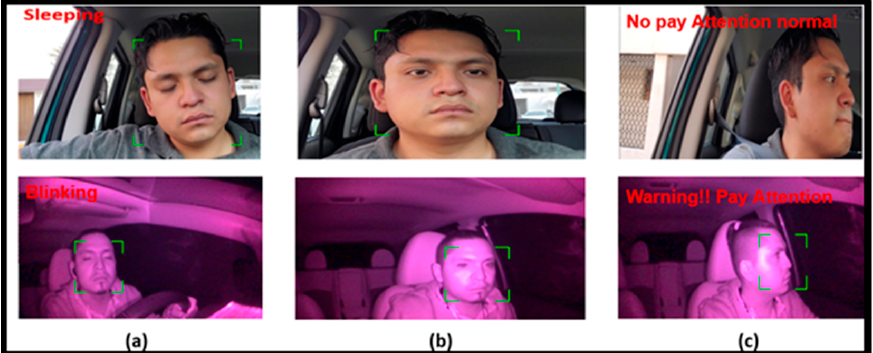
Figure 26. The functionality of the light alert subsystem (LAS), ( a ) activation of the LAS when the driver is distracted, and ( b ) activation of the LAS when the driver is asleep.